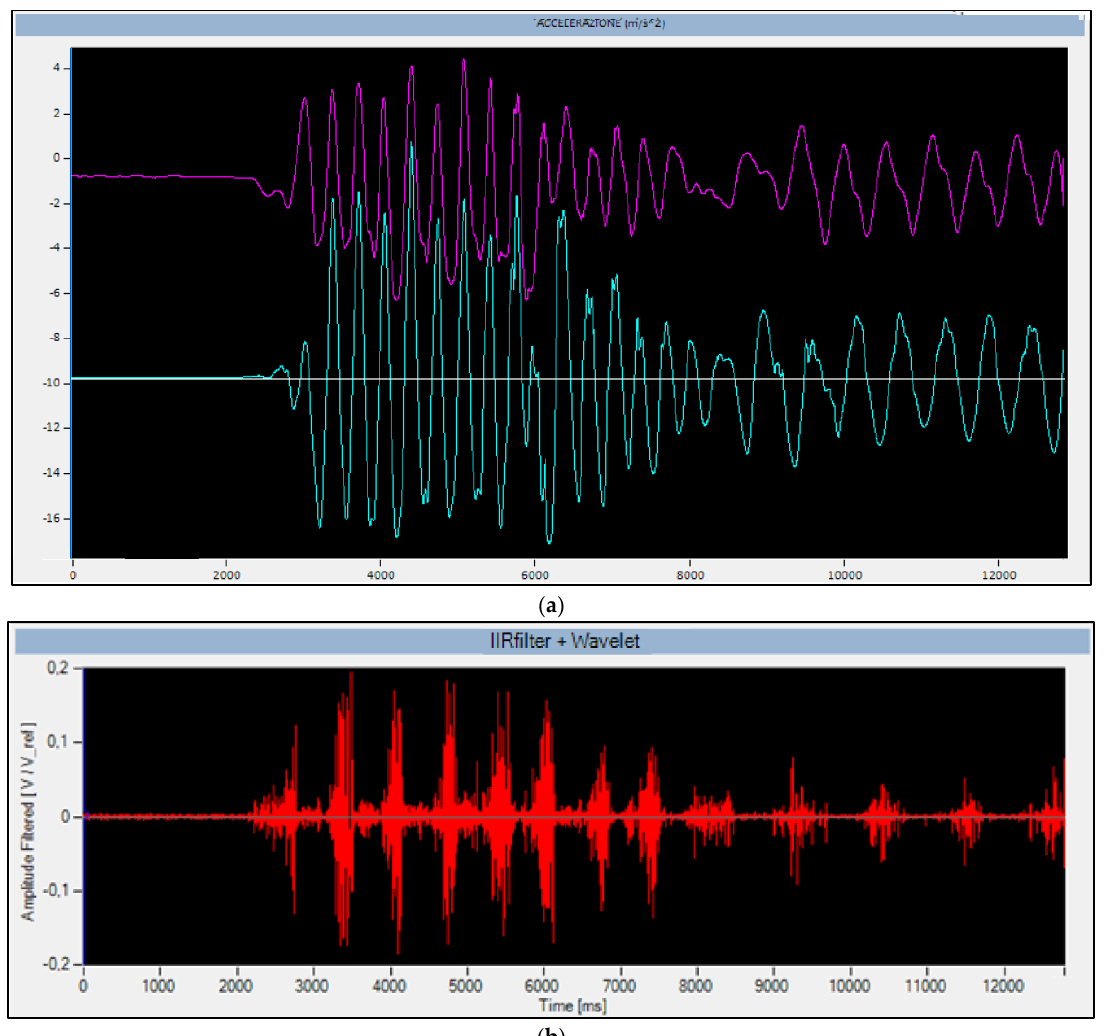
Figure 4. Run performance: ( a ) accelerometer signal in the vertical direction (cyan) and front direction (purple), and sEMG signal of the vastus lateralis muscle ( b ) raw wavelet